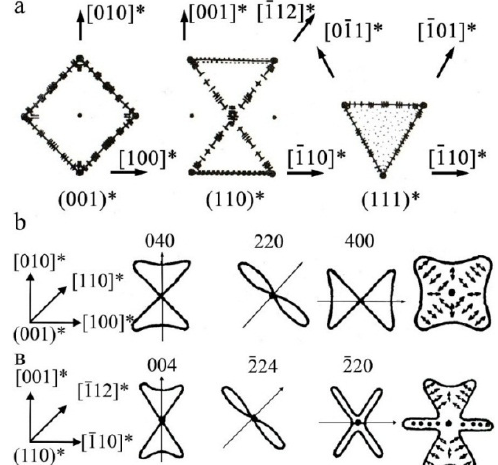
Figure 14. Atomic displacement wave spectra in the form of plane cross-sections (001)*, (110)*, and (111)* of reciprocal k -space ( a ) and in the vicinity of reciprocal lattice nodes of the planes (001)* and (110)* ( b , c ). Projections of e k for k wave of enhanced amplitude and, consequently, more intensive diffuse scattering are marked by dots, arrows, and dashes [62].